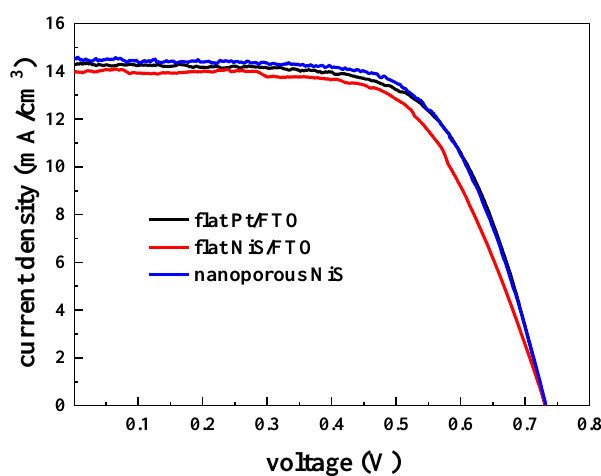
Figure 6. Photocurrent-voltage (J-V) characteristic curves of nanoporous NiS, flat NiS/FTO, and flat Pt/FTO, which were measured under simulated sunlight (100 mW/cm 2 , AM 1.5).